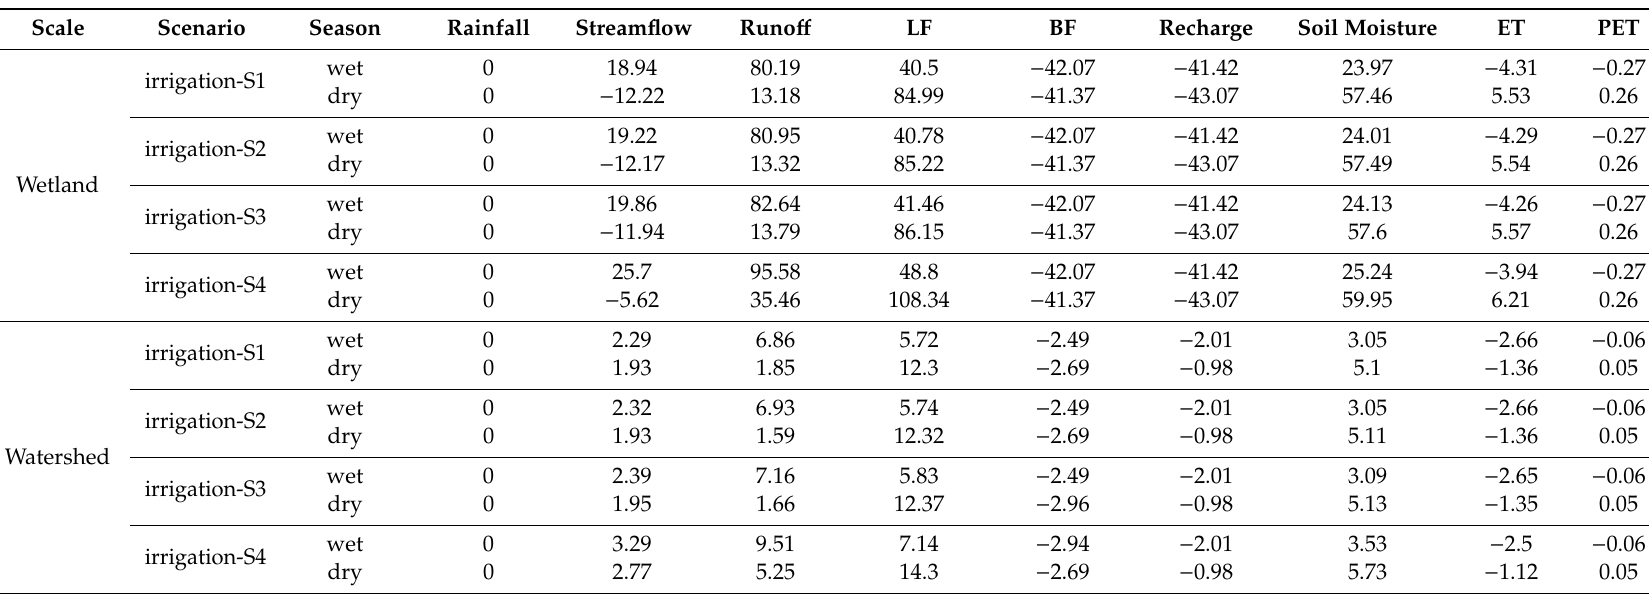
Table 6. The percent changes in the seasonal water balance components (WBCs) relative to the baseline for the Heeia Wetland and Watershed. LF = Lateral flow; BF = Base flow; ET = Evapotranspiration; PET = Potential Evapotranspiration (except rainfall, all are SWAT outputs). Scale Scenario Season Rainfall Streamflow PET